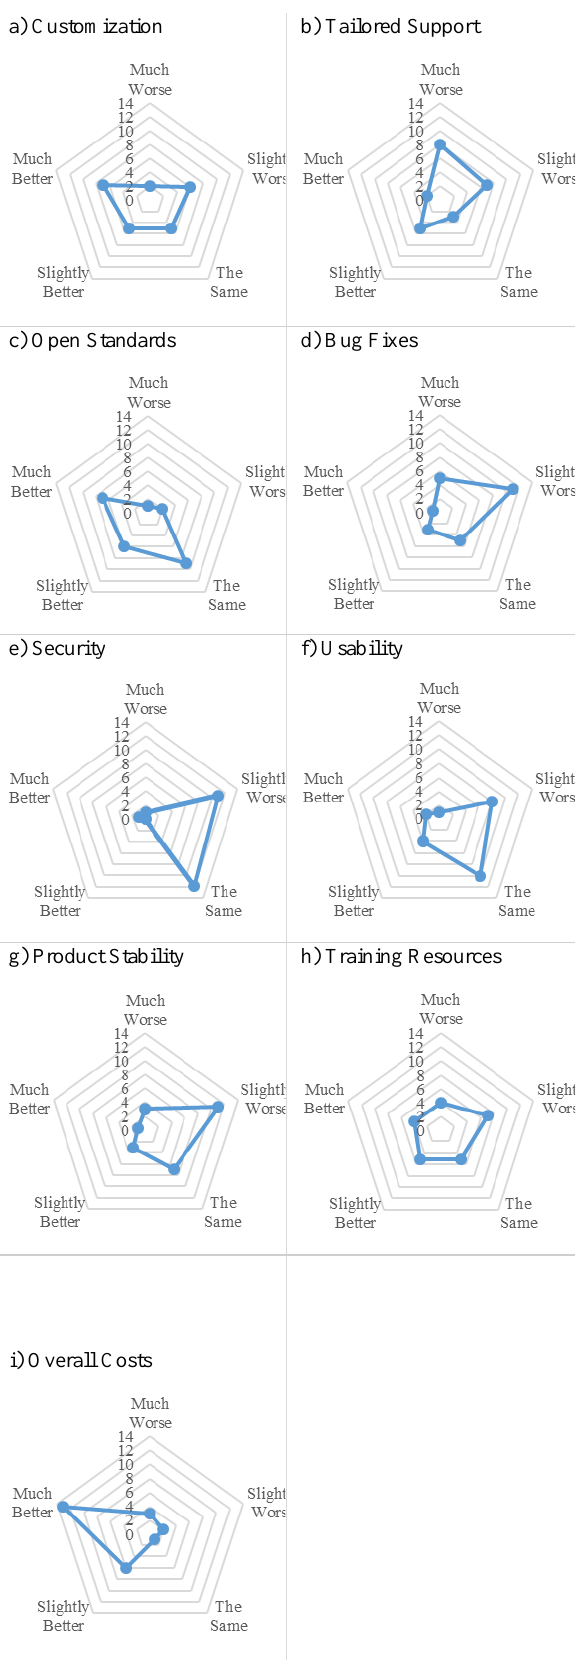
Figure 1: Comparison of open source vs. proprietary software The survey also enquired about the perception that the UN staff have of the open source software in comparison to